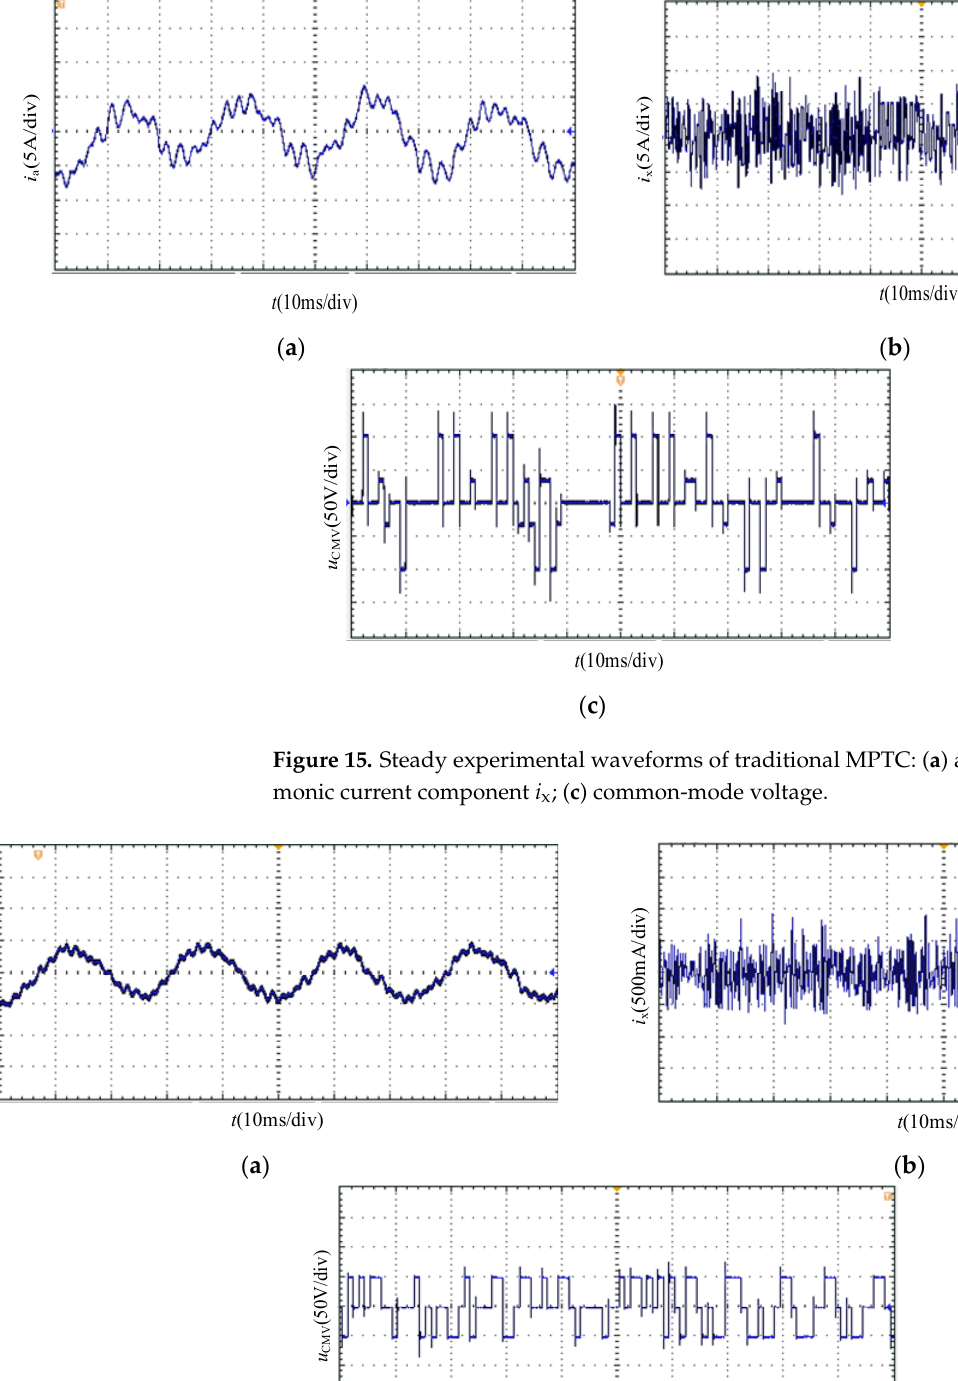
Figure 14. Experimental platform. The steady a-phase current i a , harmonic current i x , and the common-mode voltage u CMV with different control strategies are shown in Figures 15–17.